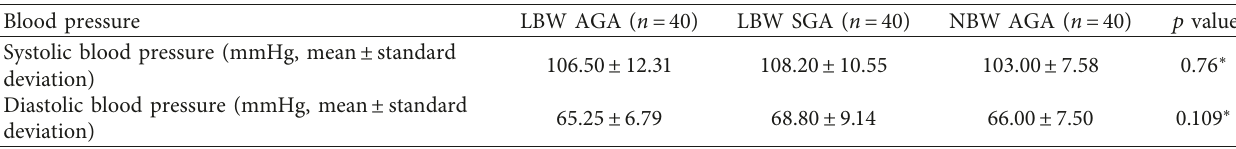
Table 2: Association between children with LBW SGA, LBW AGA, and NBW AGA with systolic and diastolic blood pressure.